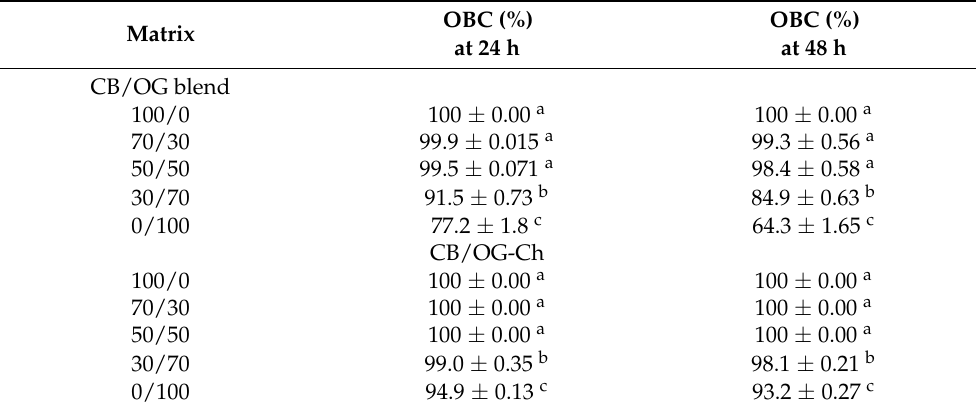
Table 8. Oil-binding capacity (OBC) in the different formulated CB/OG blends and CB/OG-based chocolate (CB/OG-Ch) counterparts.